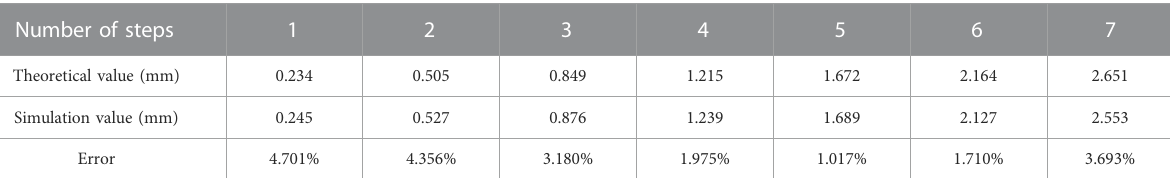
TABLE 6 Equivalent temperature loading error.